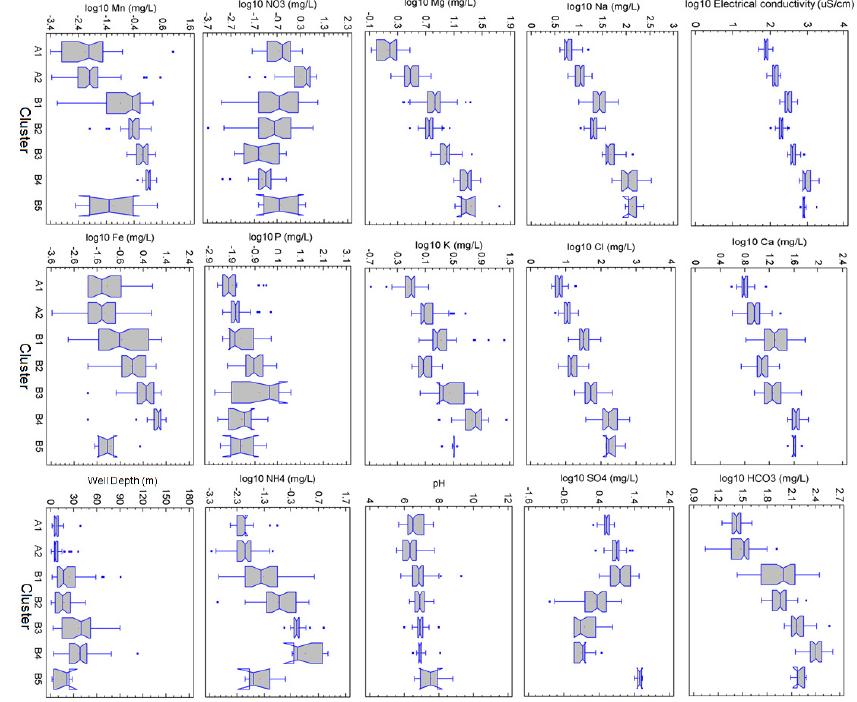
Fig. 5. Box-Whisker plots showing the variations across the seven clusters (A1–B5) for selected water quality parameters and bore depth (m). Parameters include both those used as input to HCA and additional parameters not included in HCA but considered in later analysis.